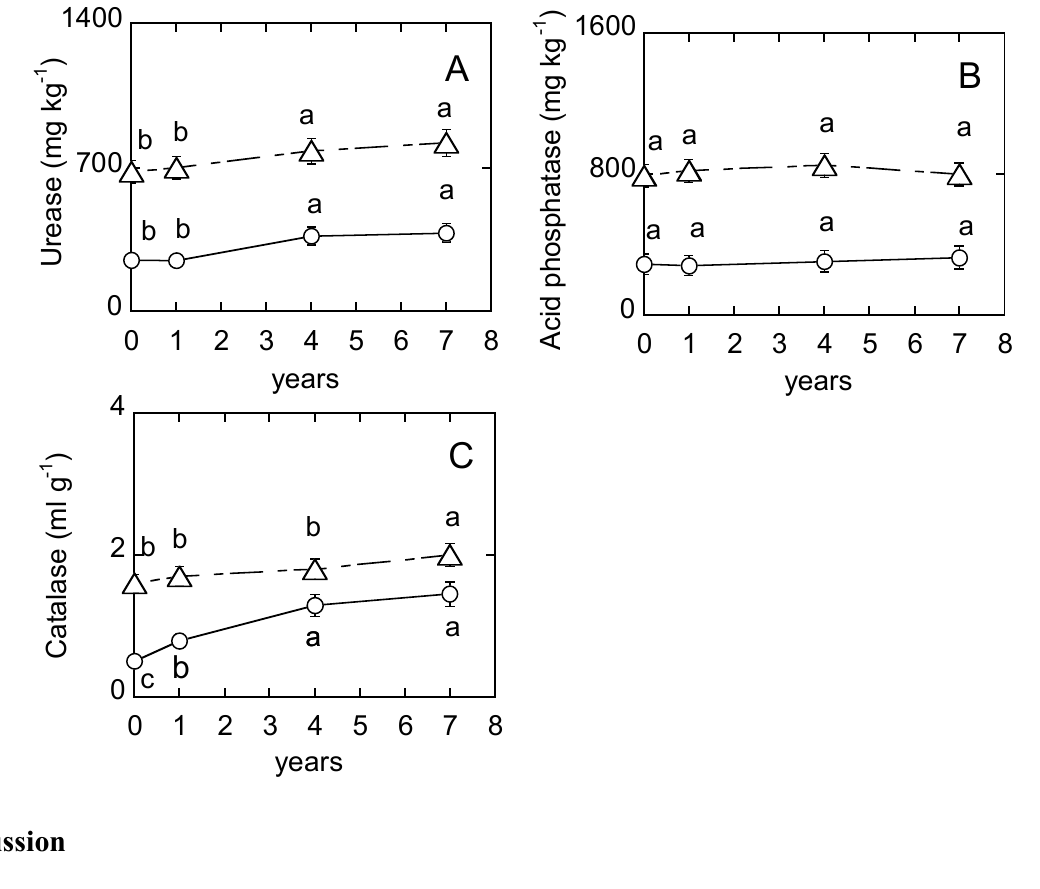
Figure 3. Soil enzyme activity along a wildfire induced time span; A , urease activity; B , acid phosphatase activity; C , catalase activity; each point represents N = 24 with the standard error of the mean indicated; ○ , burned soil; ∆ , unburned soil; standard errors are shown by vertical